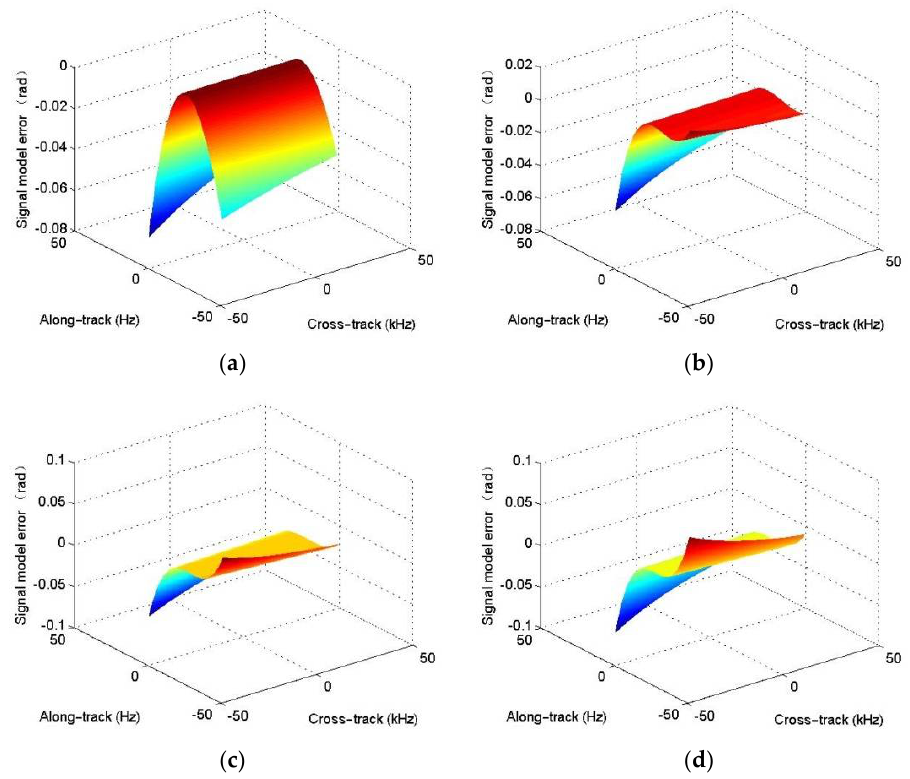
Figure 5. Signal model error for the last transmitter/receiver pair when the system works with wide-bandwidth. ( a ) r = 40 m; ( b ) r = 110 m; ( c ) r = 180 m; ( d ) r = 250